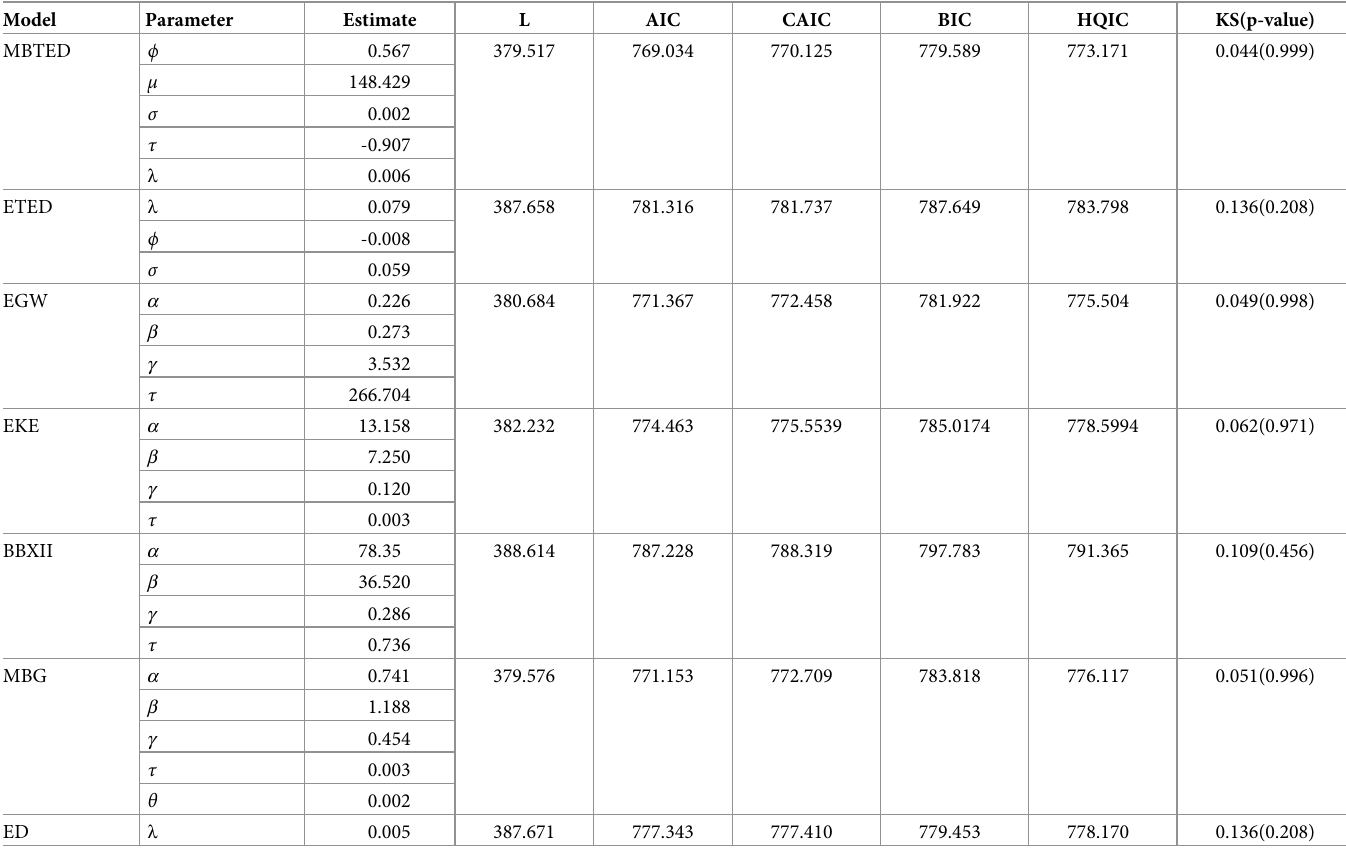
Table 7. Table displaying results of analysis of survival times of breast cancer